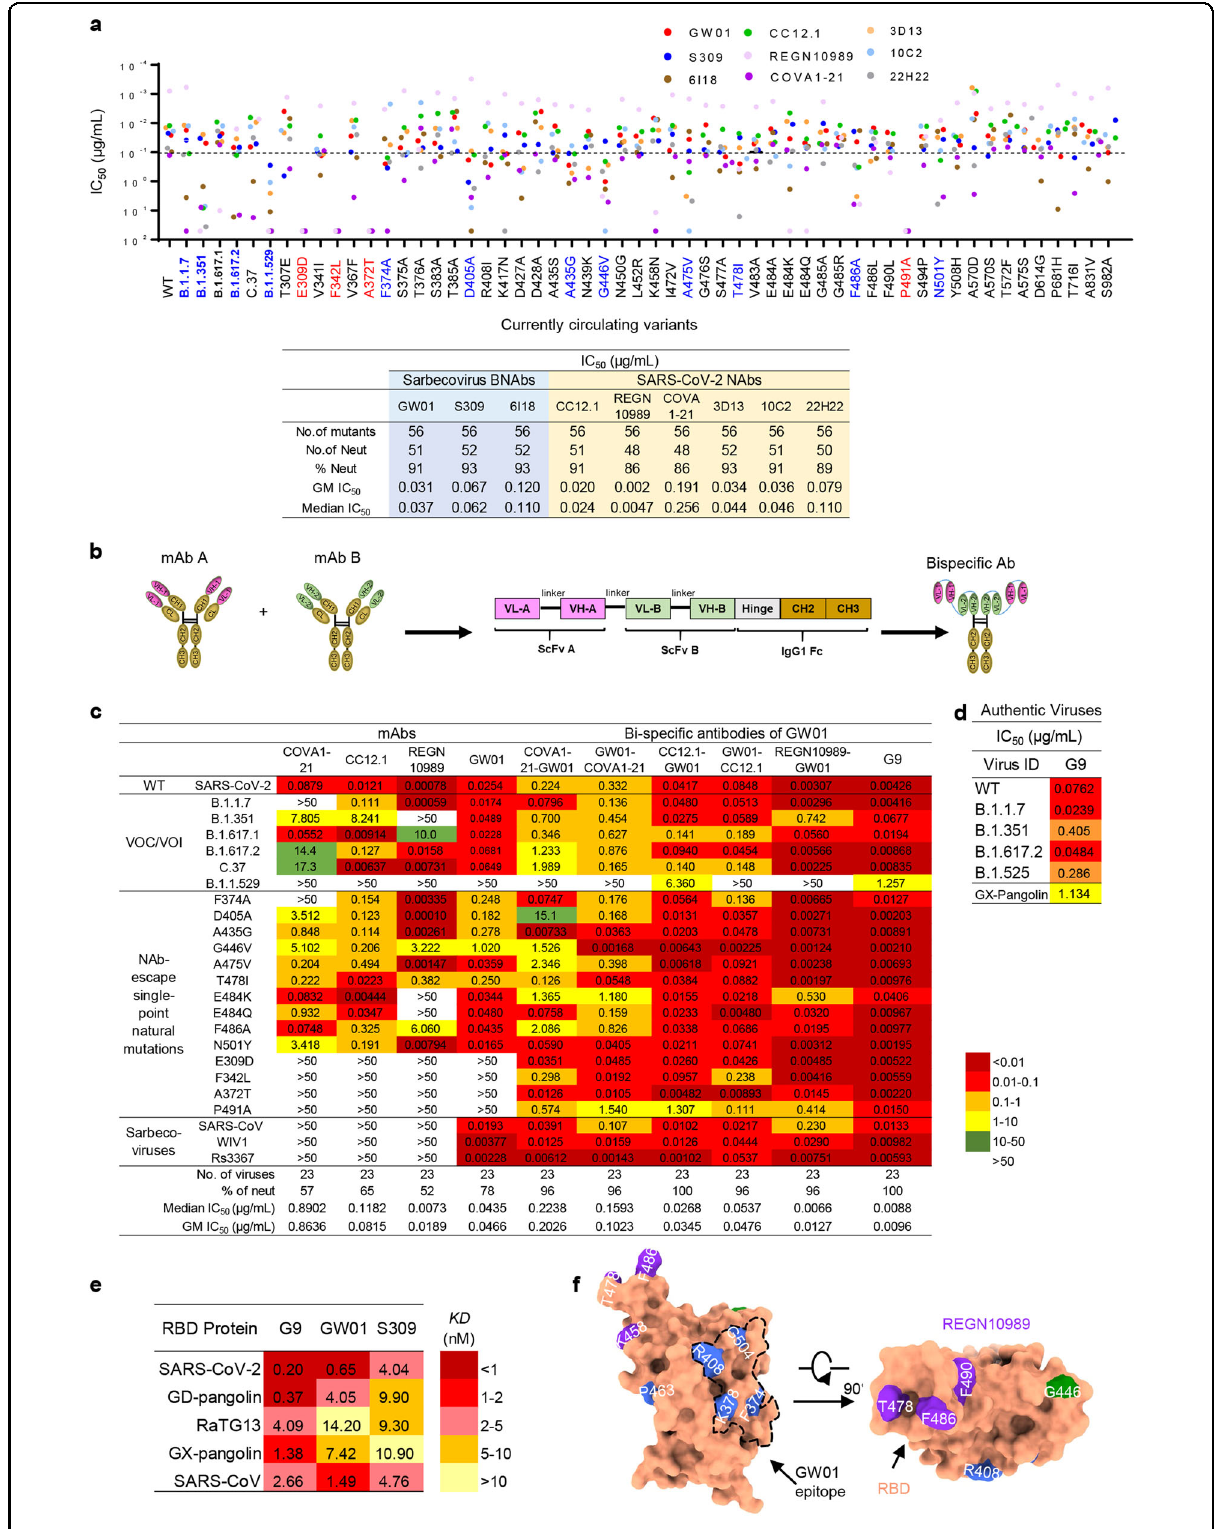
Fig. 4 (See legend on next